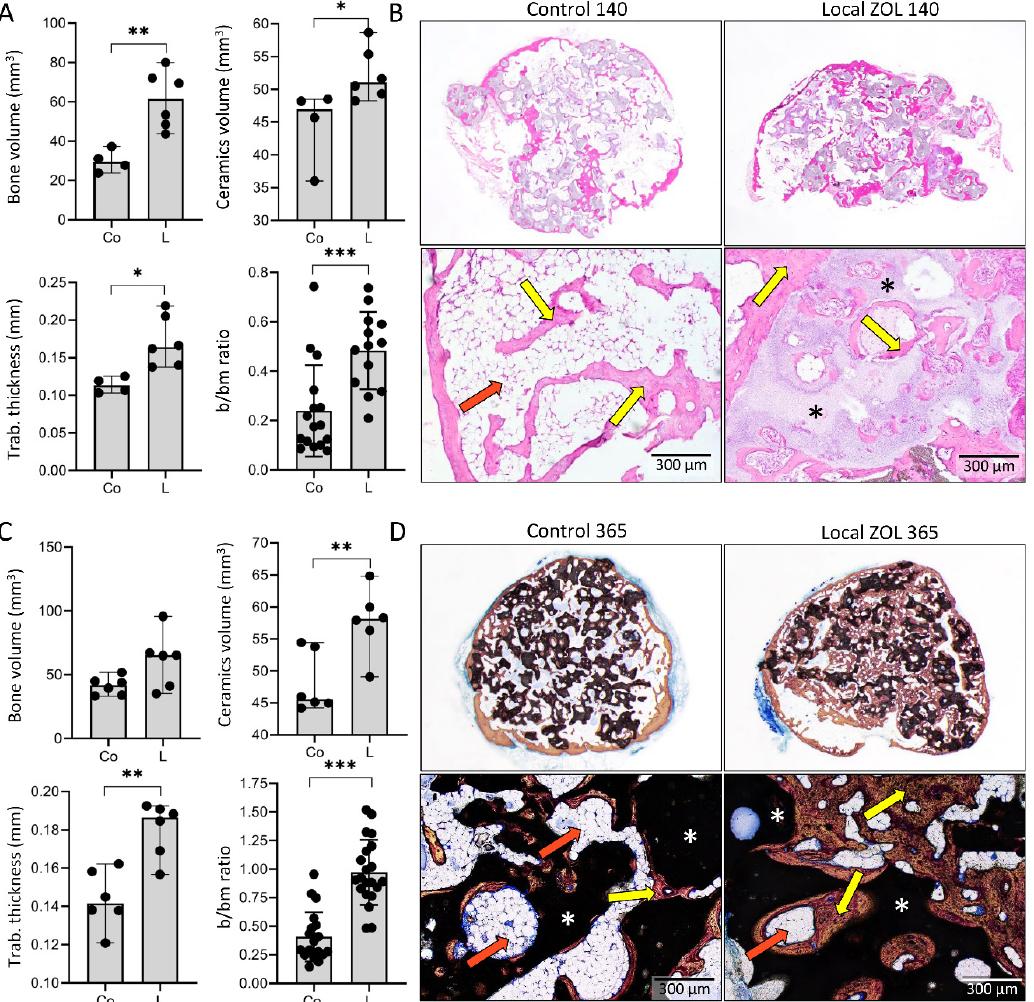
Figure 6. Effect of ZOL on the amount and microarchitecture of bone–ceramic structure (BCS) is persistent one year following the subcutaneous implantation of ABGS (rhBMP6/ABC) implants with ceramics. MicroCT parameters including bone volume (mm 3 ), ceramics volume (mm 3 ), trabecular thickness (mm), and histomorphometrically determined bone/bone marrow (b/bm) ratio on ( A ) day 140 or ( C ) day 365 among control implants (Co) and implants with locally added ZOL (L). Histological sections of BCS on ( B ) day 140 (HE stain) and ( D ) day 365 (Sanderson’s Rapid Bone Stain with Van Gieson picrofuchsin) following subcutaneous implantation of ABGS (rhBMP6/ABC) implants containing ceramics with and without ZOL. Yellow arrows indicate bone, orange arrows indicate bone marrow, while ceramics are indicated with asterisks. Scale bars are shown in the lower right corner. All P values below 0.05 were considered significant and are marked with asterisks as follows: * ( p ≤ 0.05), ** ( p ≤ 0.01), *** ( p ≤ 0.001). The microarchitecture of BCS on day 140 and 365 (long-term effect) was not different compared to day 35 and 50 (mid-term effect). BCS induced in control implants (without